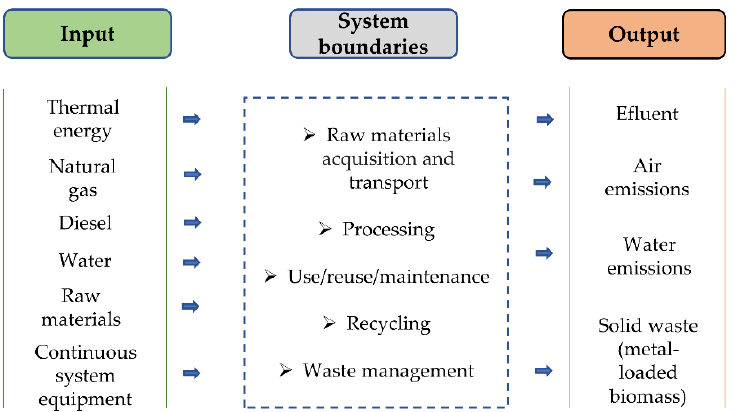
Figure 7. Overview on the Life-Cycle Inventory for the continuous removal of metal ions using microorganisms.